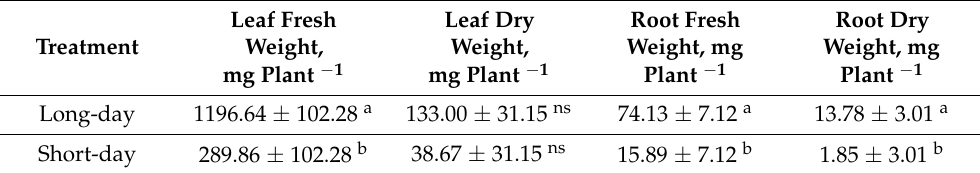
Table 2. Fresh and dry weight of leaves and roots of yellow maca plants grown in rhizoboxes under controlled conditions at long (16 h) or short (8 h) day length. The measurements were performed after harvest (88 DAS). Results represent mean values ± SEM of three independent